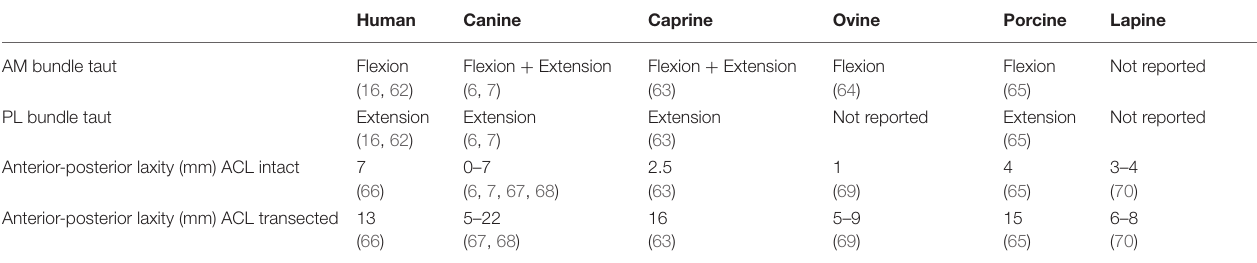
TABLE 3 | Comparison of biomechanical characteristics between humans and large animal